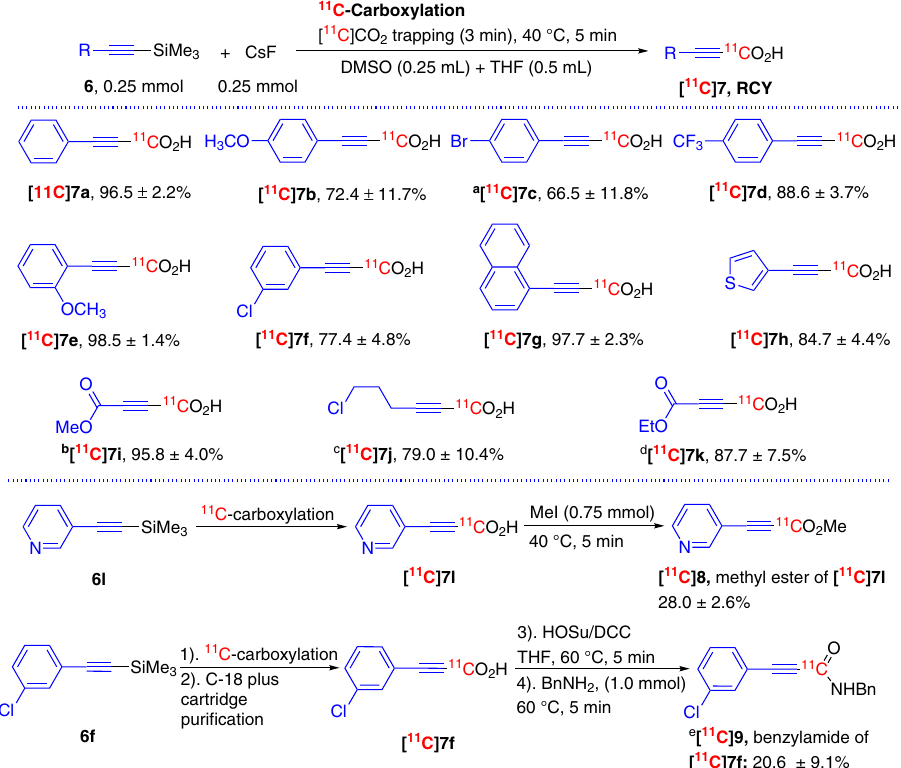
Fig. 2 FMDS 11 C-carboxylation with sp-hybridized carbon attached trimethylsilanes. Unless otherwise indicated, the reported values are radiochemical yields (RCY, n = 3) of determined by radio-HPLC analysis of the crude product and the product identities were determined by co-injection with corresponding carbon-12 standards. a THF (0.5 mL) + DMF (0.25 mL) were used; b Reaction was maintained at r.t., 2 min; c DMSO was used as solvent; d Precursor (0.029 mmol, 5 mg) and DMF (0.3 mL) were used for